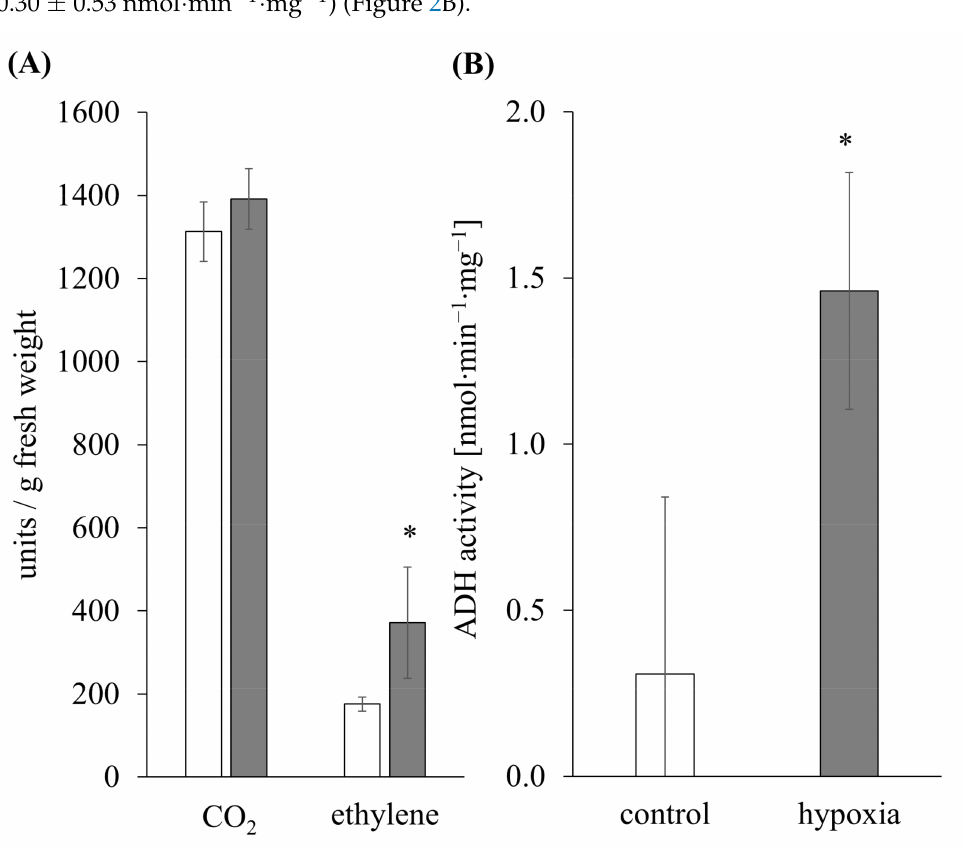
Figure 2. Physiological changes of maize plants under 24 h of hypoxia. ( A ) CO 2 and the gaseous plant hormone ethylene were analyzed in control (white columns) and 24 h hypoxia-stressed maize roots (gray columns) using a Shimadzu GC-14A gas chromatograph for three biological and two technical replicates per sample. The amounts were normalized to the fresh weight of the roots. Error bars indicate standard deviation. Significances are indicated with asterisk ( p < 0.05 *) determined with Student ´ s t -test ( n = 3). ( B ) The activities of the alcohol dehydrogenase (ADH) were determined three times for three biological replicates of control and 24 h hypoxia-stressed maize roots. Error bars indicate standard deviation. Significances are indicated with asterisk ( p < 0.05 *) determined with Student ´ s t -test ( n =